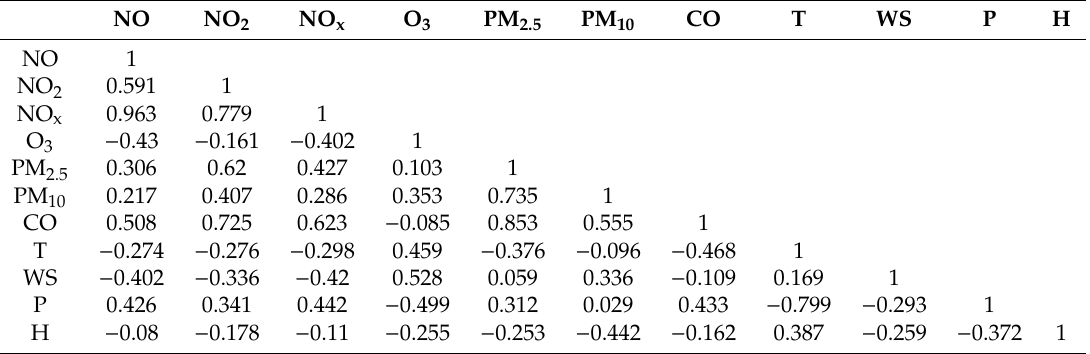
Table 2. Correlation of NO x , NO 2 , and NO and other influencing